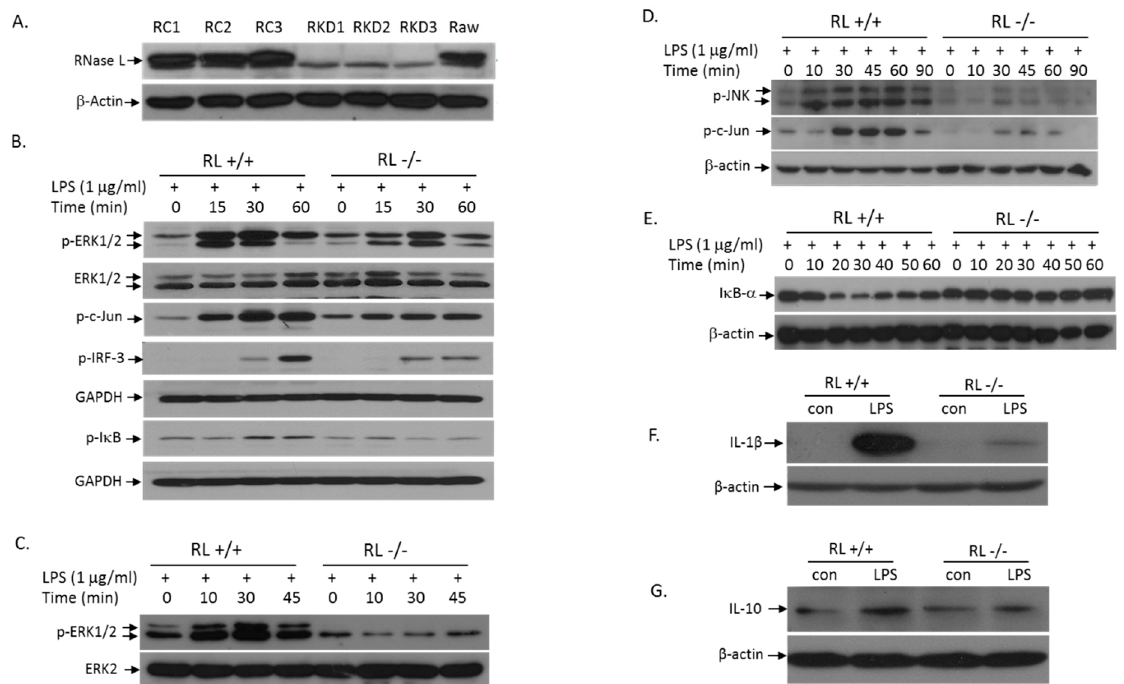
Figure 4. Absence of RNase L attenuates LPS-activation of the TLR4 signaling pathway. RNase L was knocked down in Raw 264.7 cells with RNase L shRNA as described in Methods. Empty lentiviral particles (Santa Cruz, Dallas, TX, USA) served as control. The expression of RNase L in control